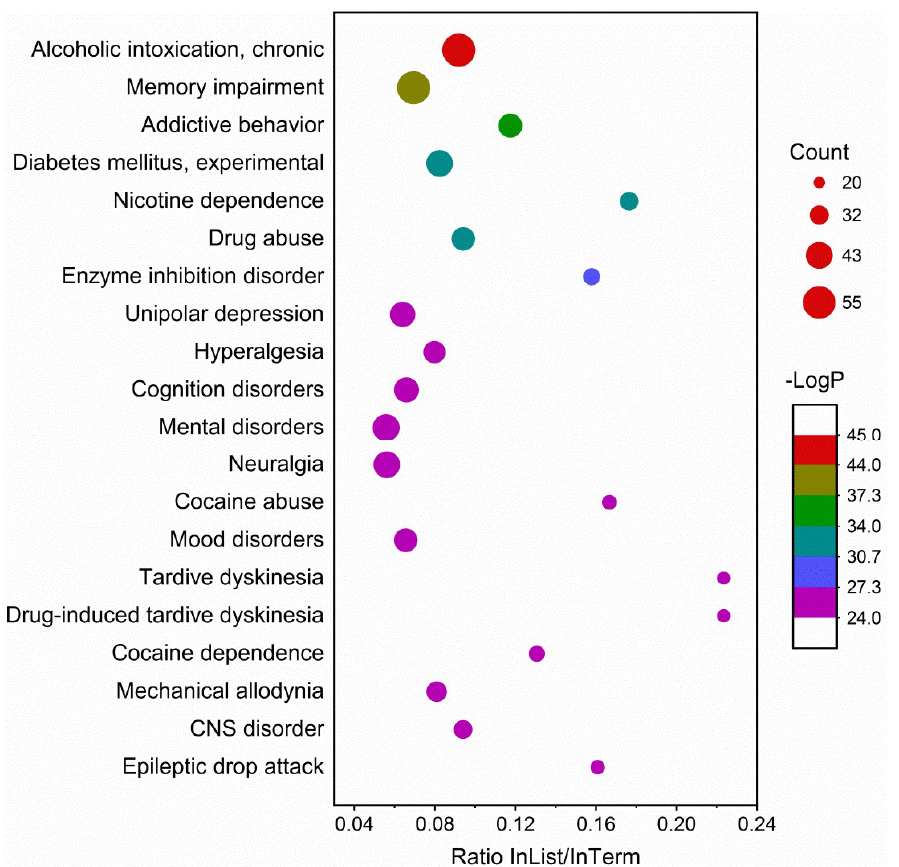
Figure 9. Enrichment analysis on DisGeNET that demonstrates the representative top 20 enriched diseases. Count, the number of input genes that fall into this term; − Log P, the minus of p -value in log base 10; InList/InTerm ratio, the ratio of the gene count in the list that hit the term to the total gene count of this